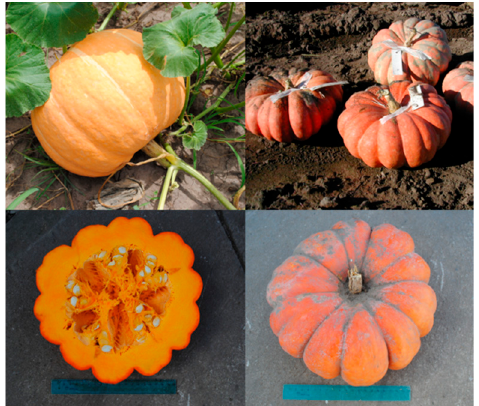
Figure 11. Fruits of Moranga cultivar ‐ group, lower row, sliced fruit showing five locules. Blue ruler length 20 cm.